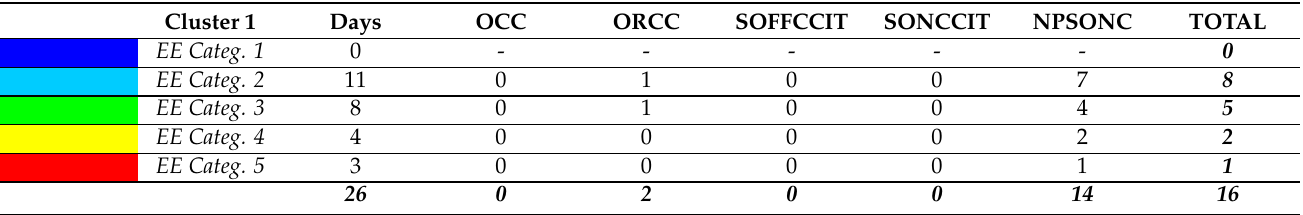
Table 5. Cluster 3.1 anomaly distribution. Each EE Category is associated with a color as depicted in Figure